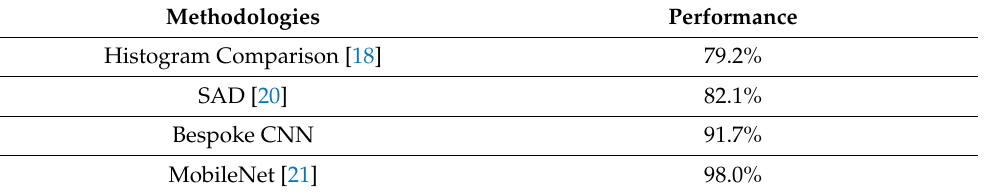
Table 1. Comparation of performance of different algorithms applied to the developed